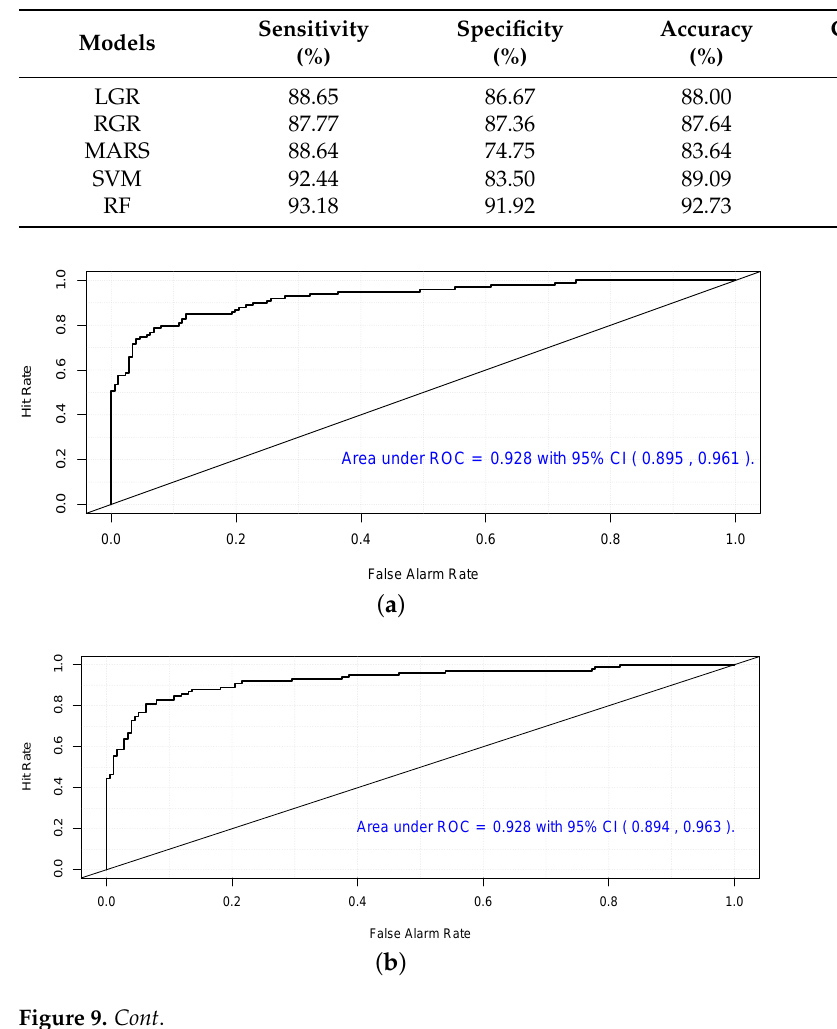
Table 7. Model evaluation using classification metrics